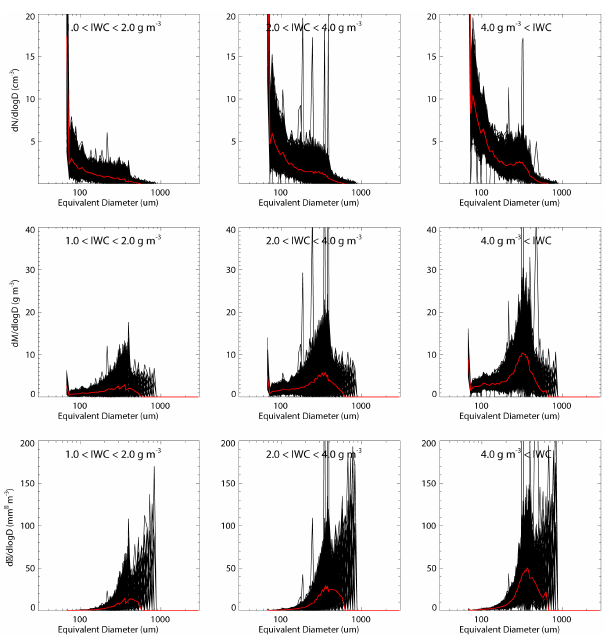
Figure 4. Cayenne flight F1423 ice number size distribution (top row), mass size distribution (middle row), and equivalent radar re- flectivity size distribution (bottom row) in three ice water content (IWC) ranges: 1–2gm − 3 (left column), 2–4gm − 3 (middle col- umn), and > 4gm − 3 (right column). Measurements from the an- alyzed time period 11:30–13:20UTC on 16 May 2010, during spi- rals within an MCS (cf. Figs. 3 and 5). Red line indicates bin-wise median size distribution.